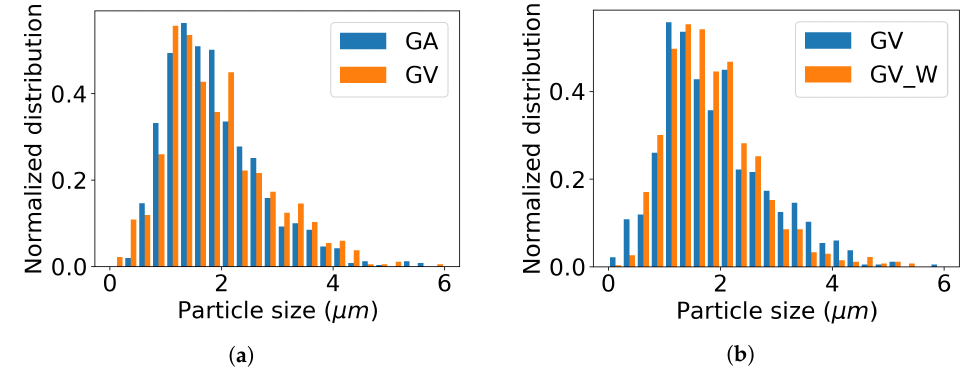
Figure 4. Particle size distribution of ( a ) the GA1000 and GV1000 samples and ( b ) the GV1000 and GV1000_W samples Table 1. Mean particle size ( µ m) of the GA1000, GA1000_W, GV1000, and GV1000_W samples, obtained by measuring on a large distribution of particles (more than 1000) on the SEM images. Mean Particle Size ( µ